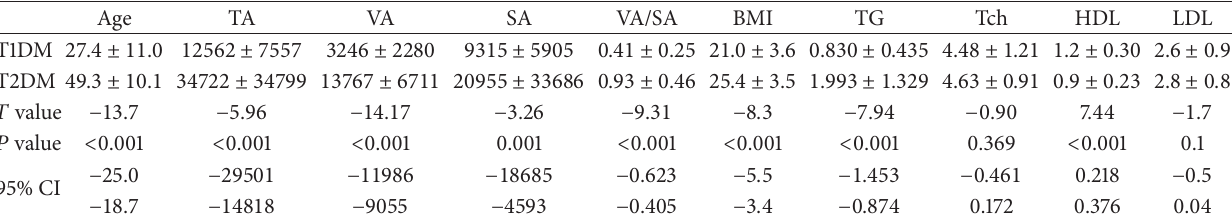
Table 1: Comparison of parameters in subjects with type 1 and type 2 diabetes.